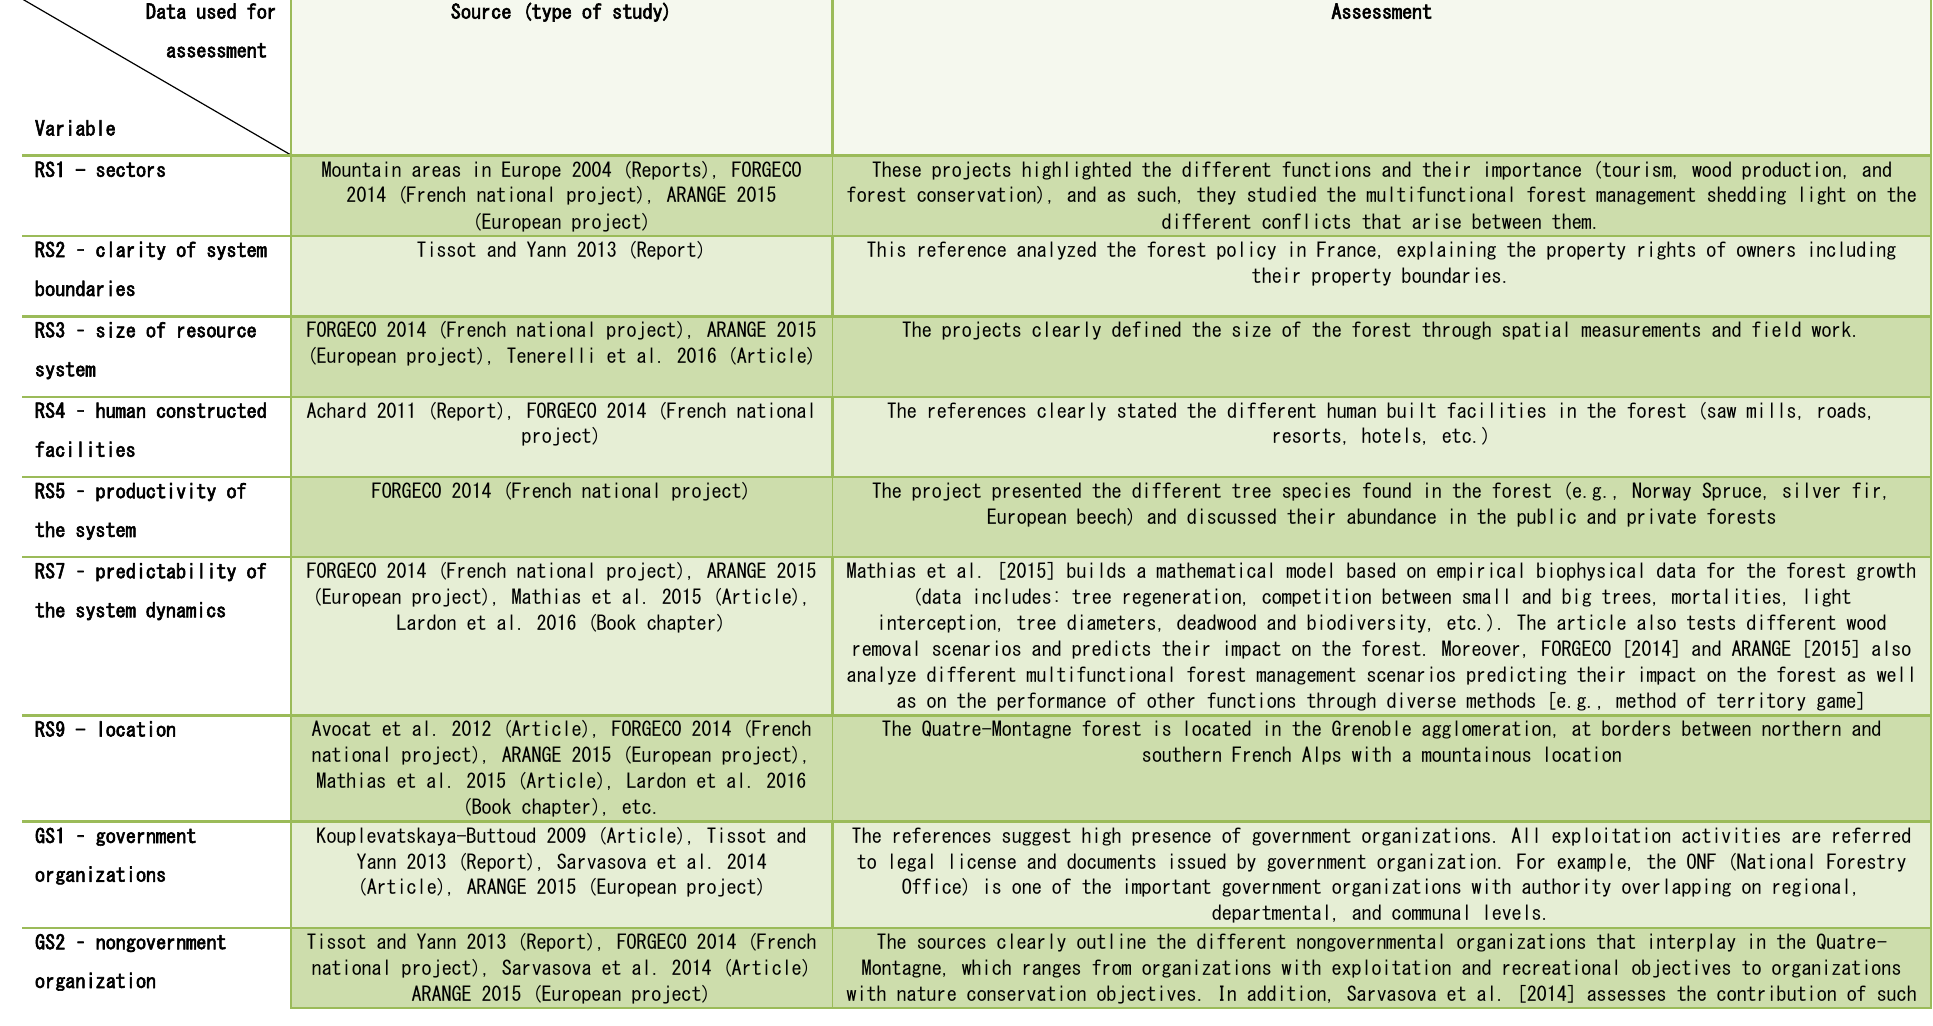
Table S1. A table presenting the relevant SES framework variables, their assessment method, and the data used to for the assessment method (source of data and type of